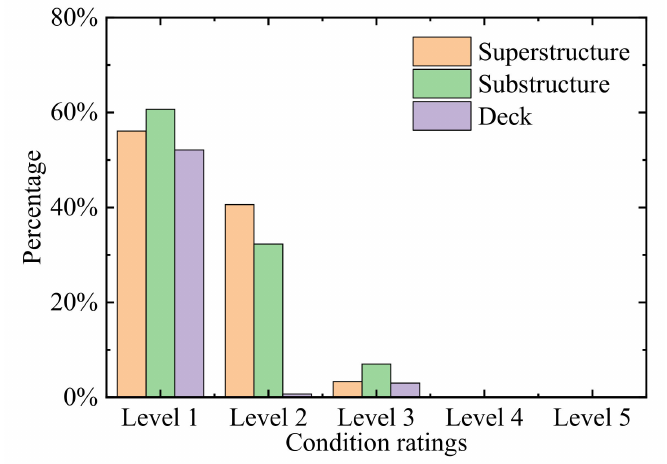
Figure 8. Superstructure, substructure, and deck ratings for bridges with an age of 5